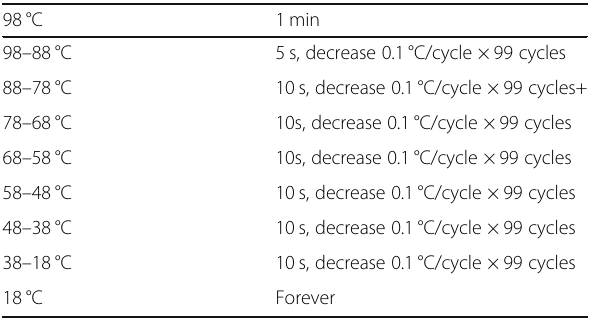
Table 2 Annealing program